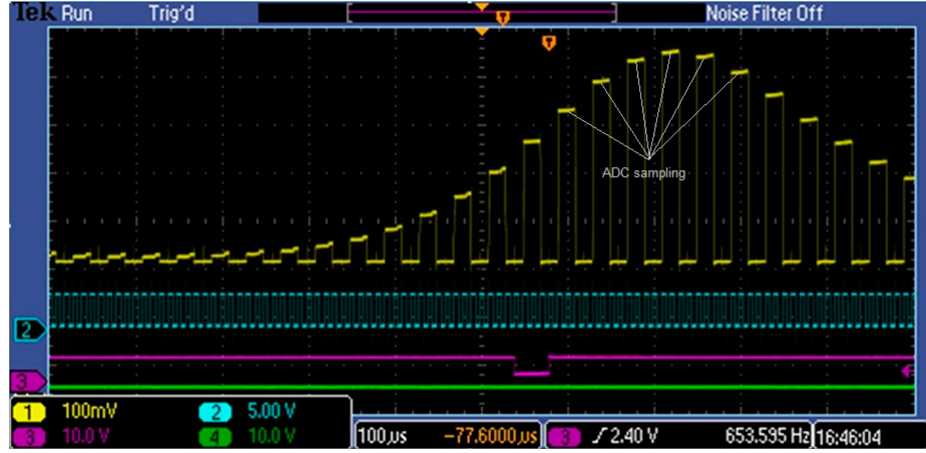
Figure 11. Video pulse sampling points.